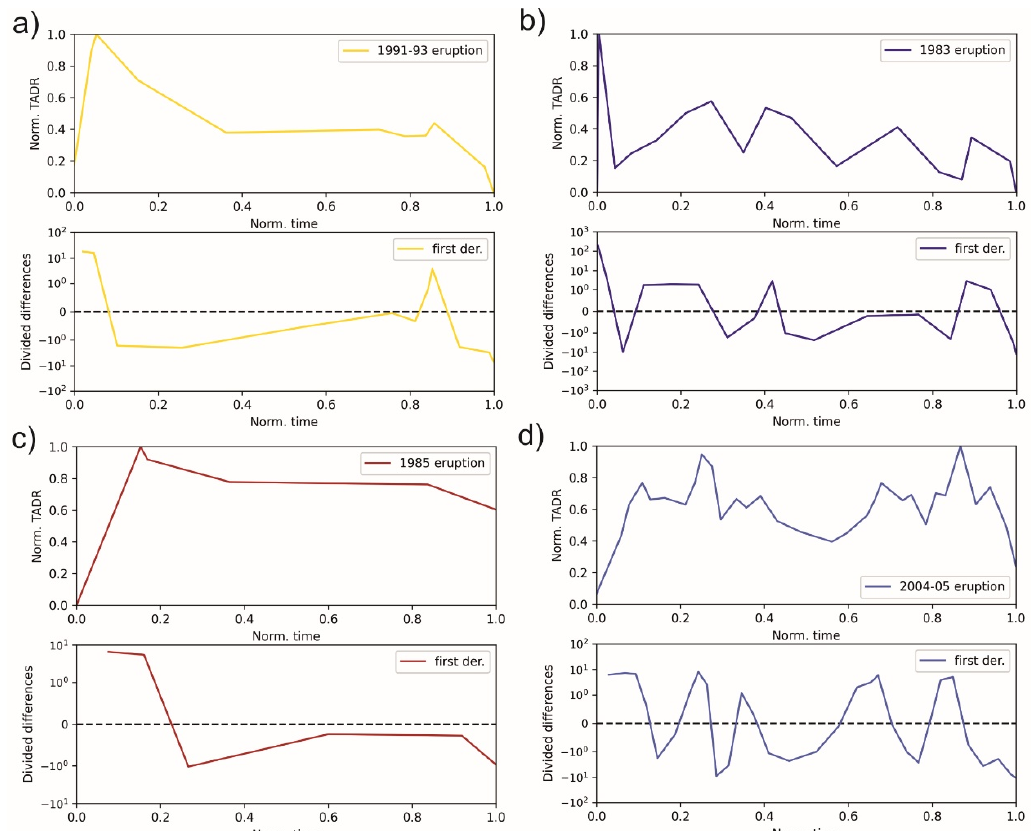
Figure 5. Examples of the first derivative calculations for the Trend 1 ( a , b ) and Trend 2 ( c , d ) TADR curves, where the inflection point is easily identified ( a , c ), while it is more difficult to identify the inflection point in more oscillating trends ( b , d )